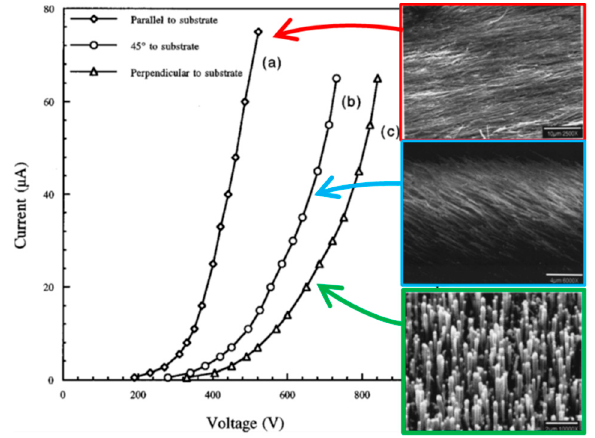
Figure 4. Field emission from the sidewalls of CNTs: the voltage–current (I–V) characteristic of films made of CNTs aligned parallel, at 45 ◦ , and perpendicular to the substrate (reprinted with permission from [95]).